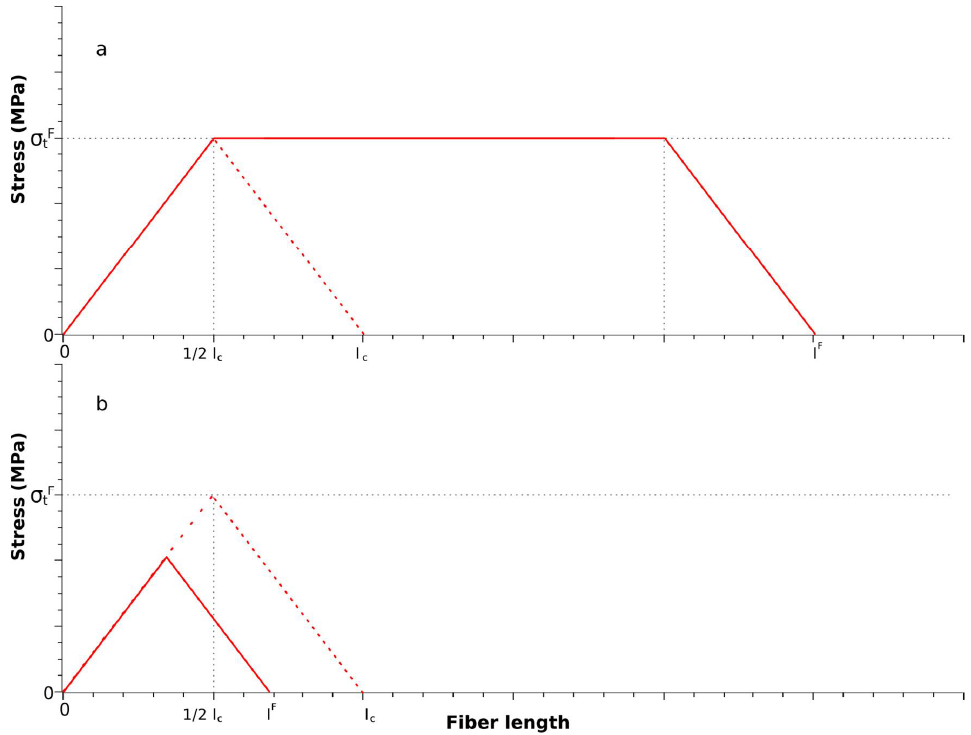
Figure 2. Axial load diagrams for ( a ) supercritical and ( b ) subcritical length fibers.